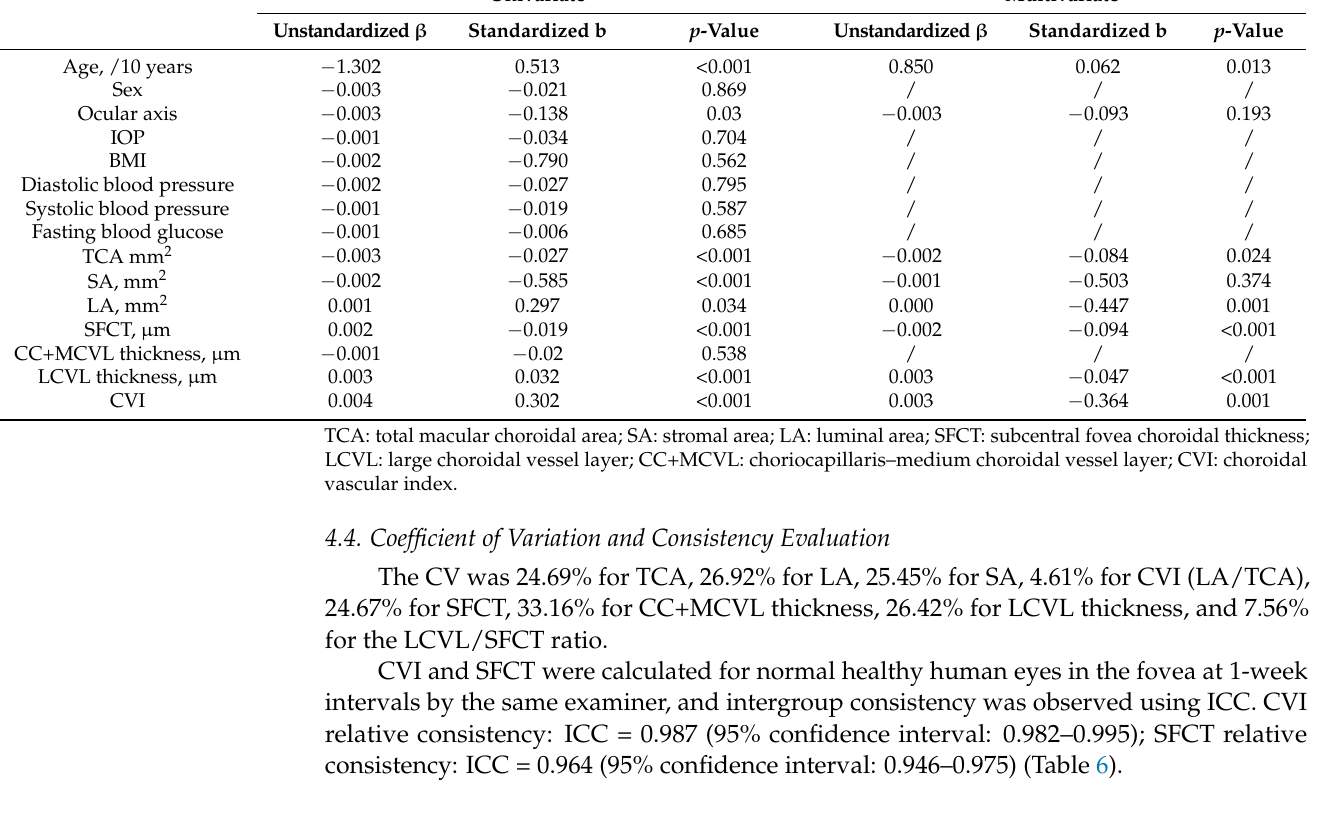
Table 5. Linear regression analysis of ocular and systemic factors correlated with LCVL/SFCT. Univariate